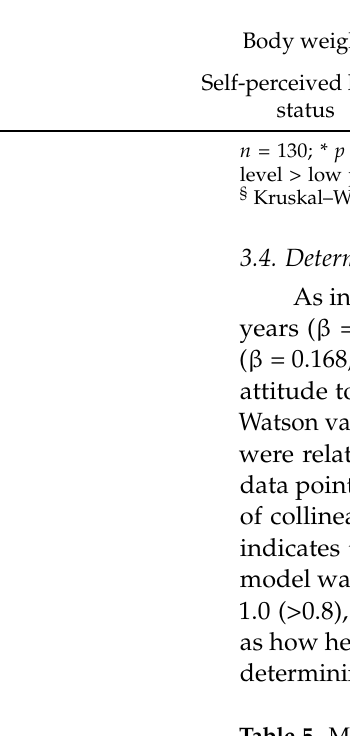
Table 5. Multiple regression model results—determinants of school counselors’ attitudes toward physical